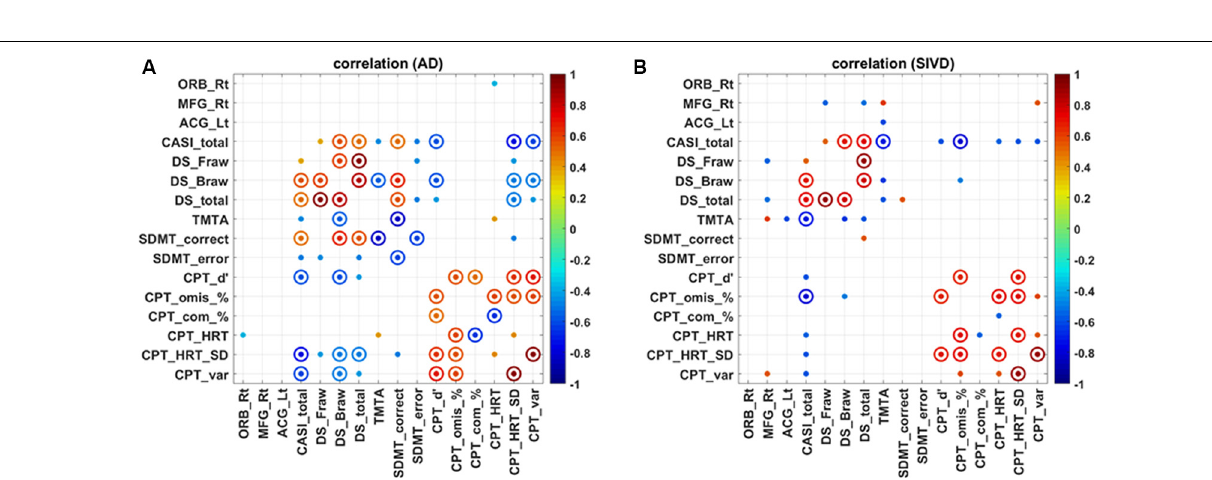
FIGURE 3 | Correlation map regarding regional homogeneity and attention in patients with Alzheimer’s disease (A) and subcortical ischemic vascular disease (B) . SIVD, subcortical ischemic vascular disease; AD, Alzheimer’s disease; ORB, orbital part of the right superior/middle/inferior frontal gyrus; MFG, middle frontal gyrus; ACG, anterior cingulate gyrus; Rt, right; Lt, left; CASI, Cognitive Abilities Screening Instrument; DS_Fraw/Braw/total, digit forward raw score/backward raw score/total; TMTA, Trail Making Test A; SDMT, Symbol Digit Modality Test; CPT3_d’/omis/com/HRT/HRT_SD/var, Conners Continuous Performance Test 3 detectability/omissions/commissions/HRT/HRT_standard deviation/variability; solid dot: p < 0.05; solid circle: p <